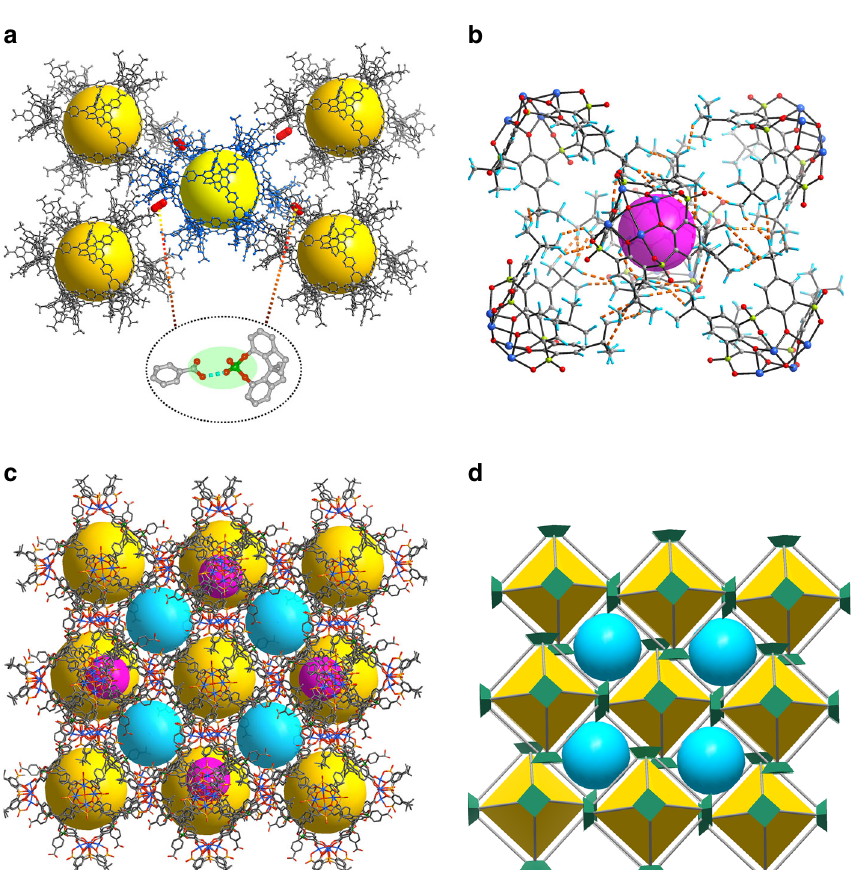
Fig. 2 Crystal structures. a Four hydrogen bonds formed between fi ve adjacent cages. b A hydrophobic cavity formed by six TBSC moieties from six cages. c The 3D HOF structure showing octahedral cages interconnected by two types of newly generated cages. d Simpli fi ed 3D packing structure. The cavities are highlighted by colored